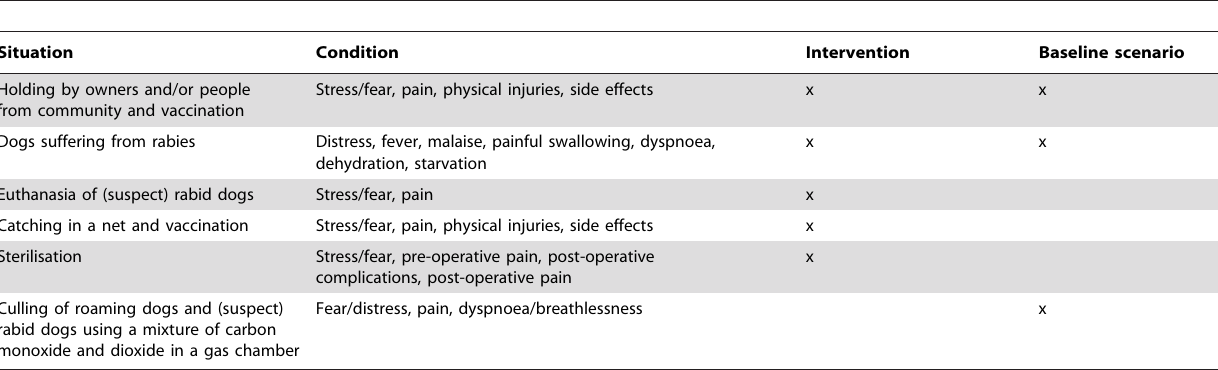
Table 3. Situations and conditions impacting on animal welfare in relation to rabies and its control in Colombo City, assessed for the intervention and/or the baseline